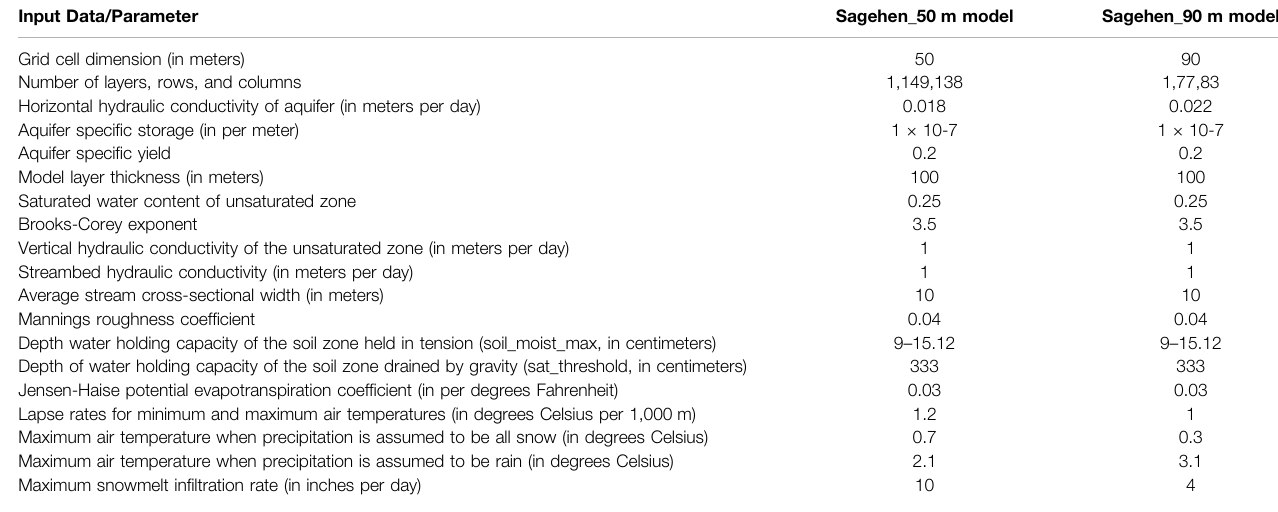
TABLE 3 | Parameter values for models using two different spatial resolutions. Parameter values were modi fi ed from their default values to calibrate the model with 50 m by 50 m horizontal discretization, and calibrated parameters for the 90 m by 90 m model. Simulated snowpack, temperature, and horizontal hydraulic conductivity values were sensitive to changes in model